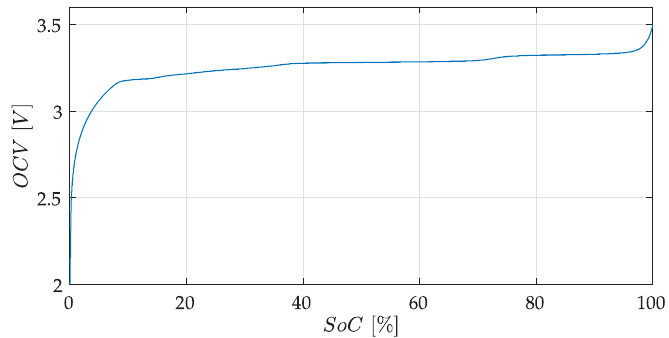
Figure 13. OCV-SoC curve referred to the A123 battery cell.